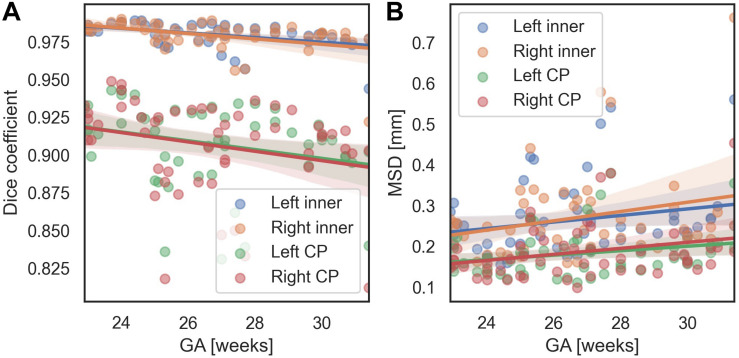
Age-related trends of segmentation accuracy of the proposed method. (A) Dice coefficient. (B) MSD.